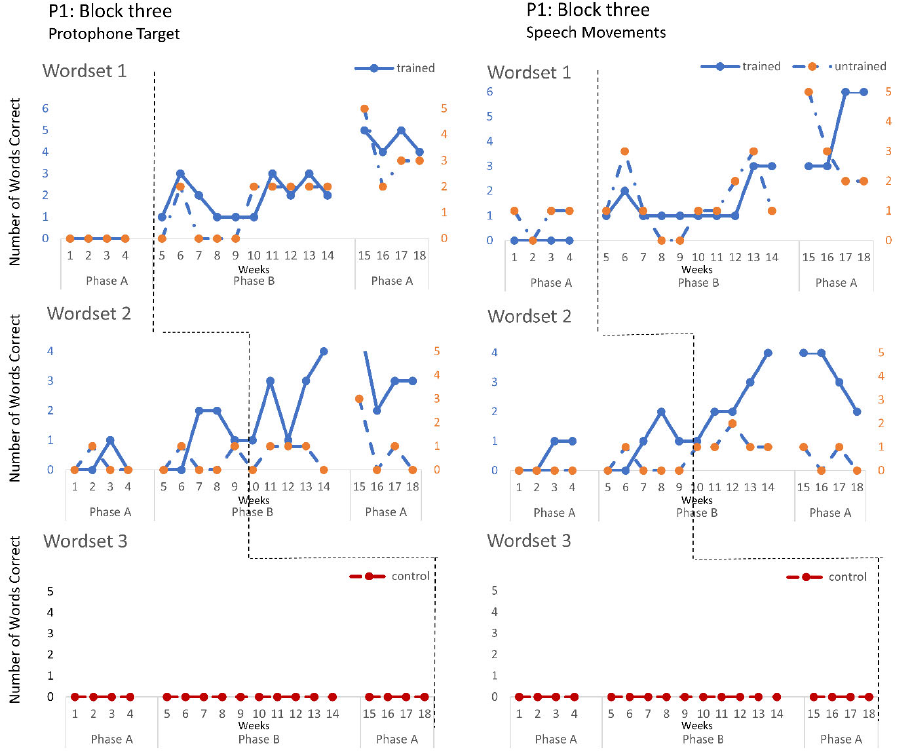
Figure 4. Accuracy of performance on the speech probes as scored for protophone target ( left ) and motor-speech movements ( right ) block three, participant 1.